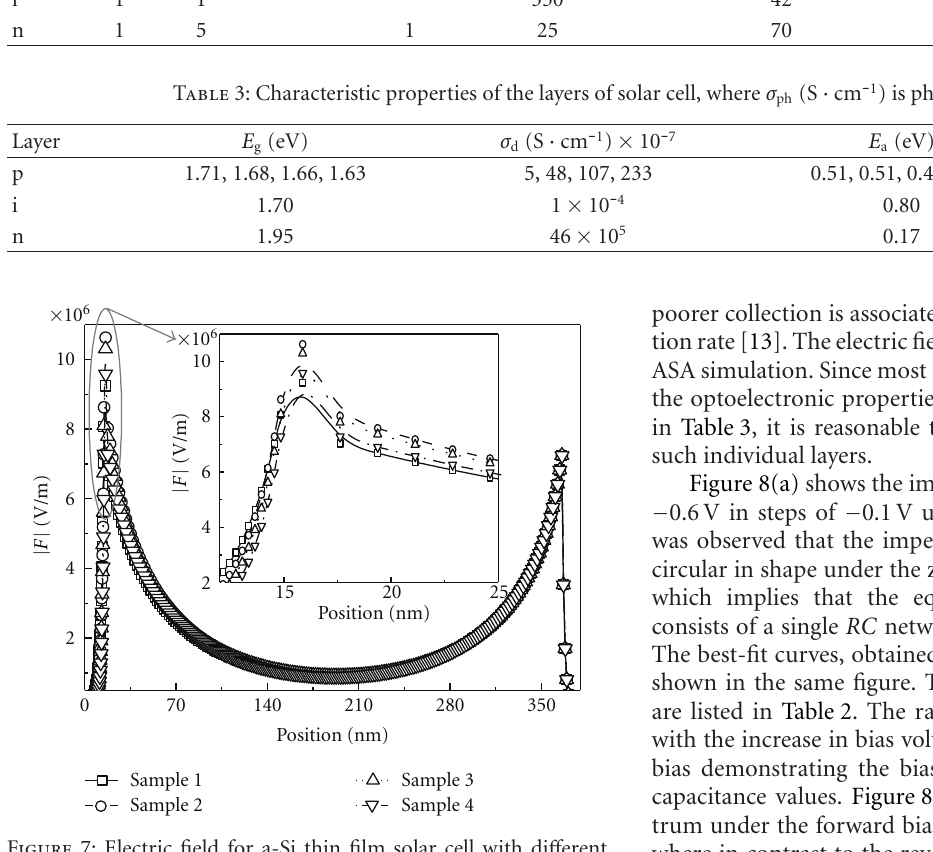
Figure 7: Electric field for a-Si thin film solar cell with di ff erent volume fraction of B 2 H 6 in SiH 4